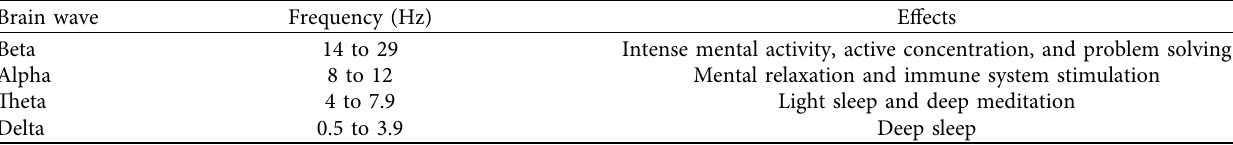
Table 1: Simplifed classifcation of brain